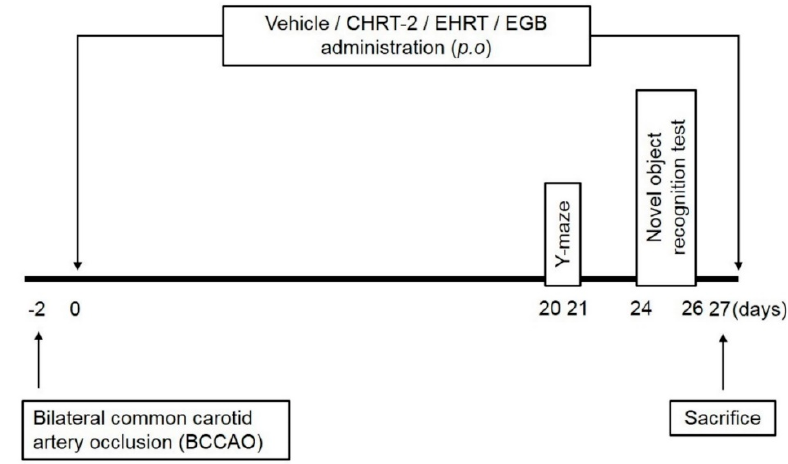
Figure 2. Schematic description of the experimental design. Sprague Dawley rats were randomly assigned to six experimental groups ( n = 8 per group). The experimental group comprised (1) the sham normal group, (2) the bilateral common carotid artery occlusion (BCCAO) group, (3) the BCCAO group treated with CHRT-2 at 200 mg/kg, (4) the BCCAO group treated with CHRT-2 at 400 mg/kg, (5) the BCCAO group treated with EHRT at 400 mg/kg, and (6) the BCCAO group treated with an extract of Ginkgo biloba (EGB) at 100 mg/kg. Oral administration of drugs was started 2 d after BCCAO induction and continued for 30 days. Y-maze and novel object recognition tests were conducted 24 h after last administration at 23 and 27 days, respectively.